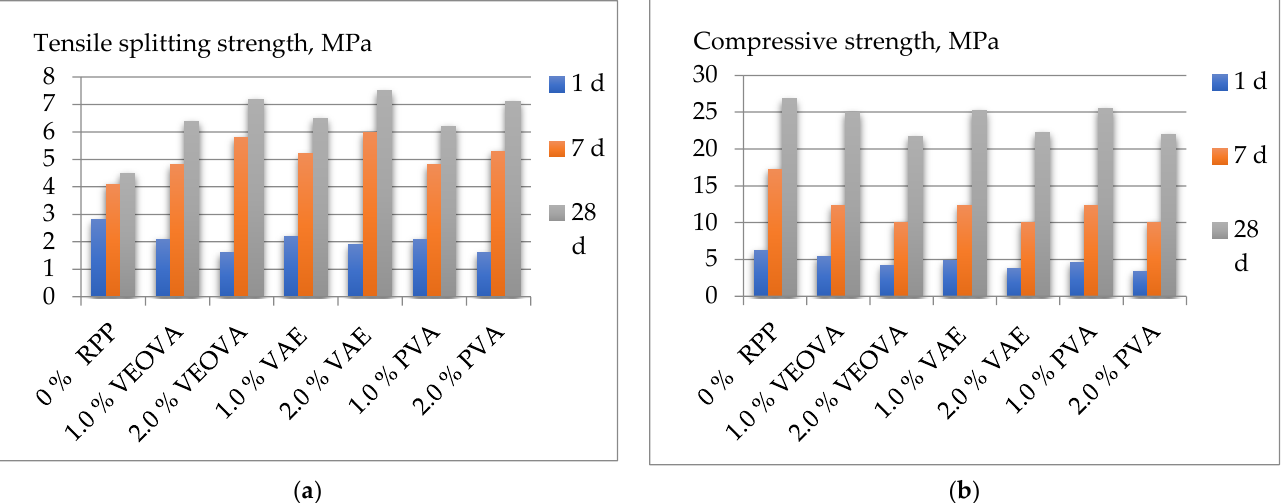
Figure 6. Results of concrete strength with the addition of RPP: ( a ) tensile splitting strength; ( b ) compressive strength.